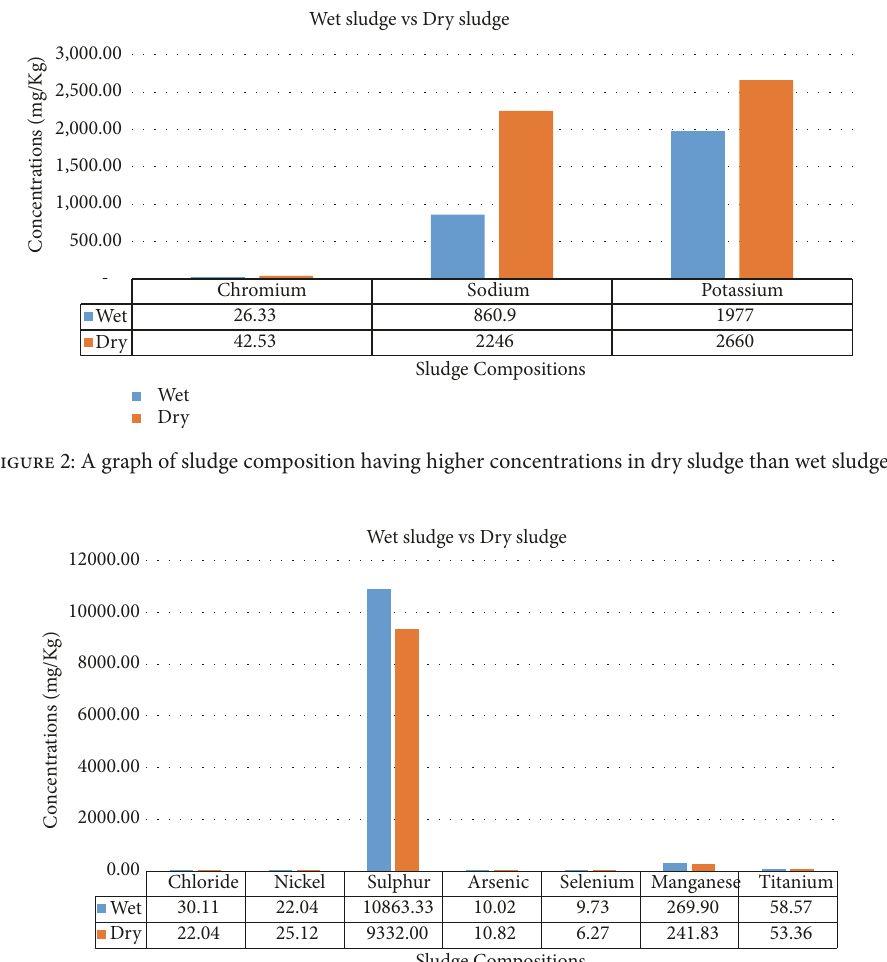
Chloride Nickel Sulphur Arsenic